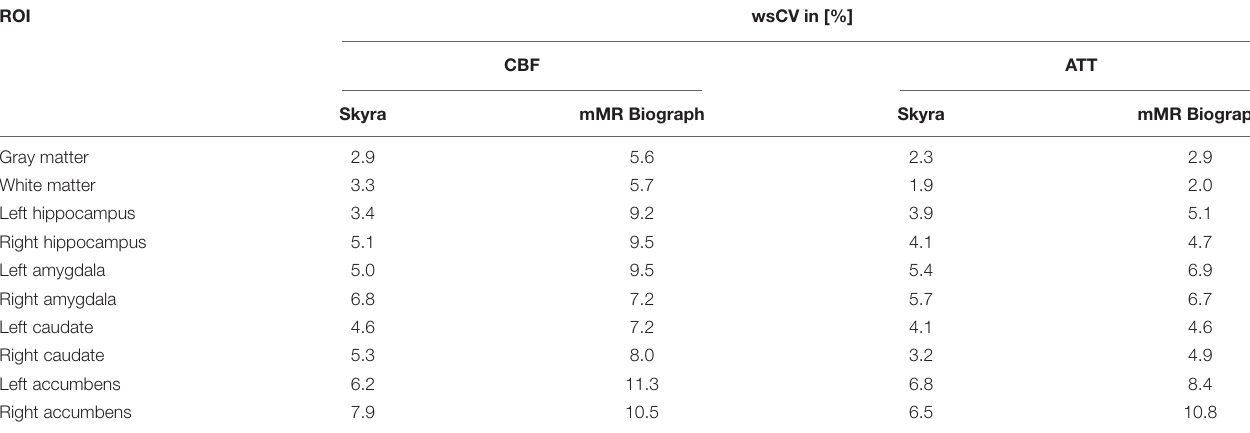
TABLE 2 | Reliability of the perfusion estimated from pseudo-continuous ASL (pCASL) acquisitions (from Skyra and mMR Biograph). ROI